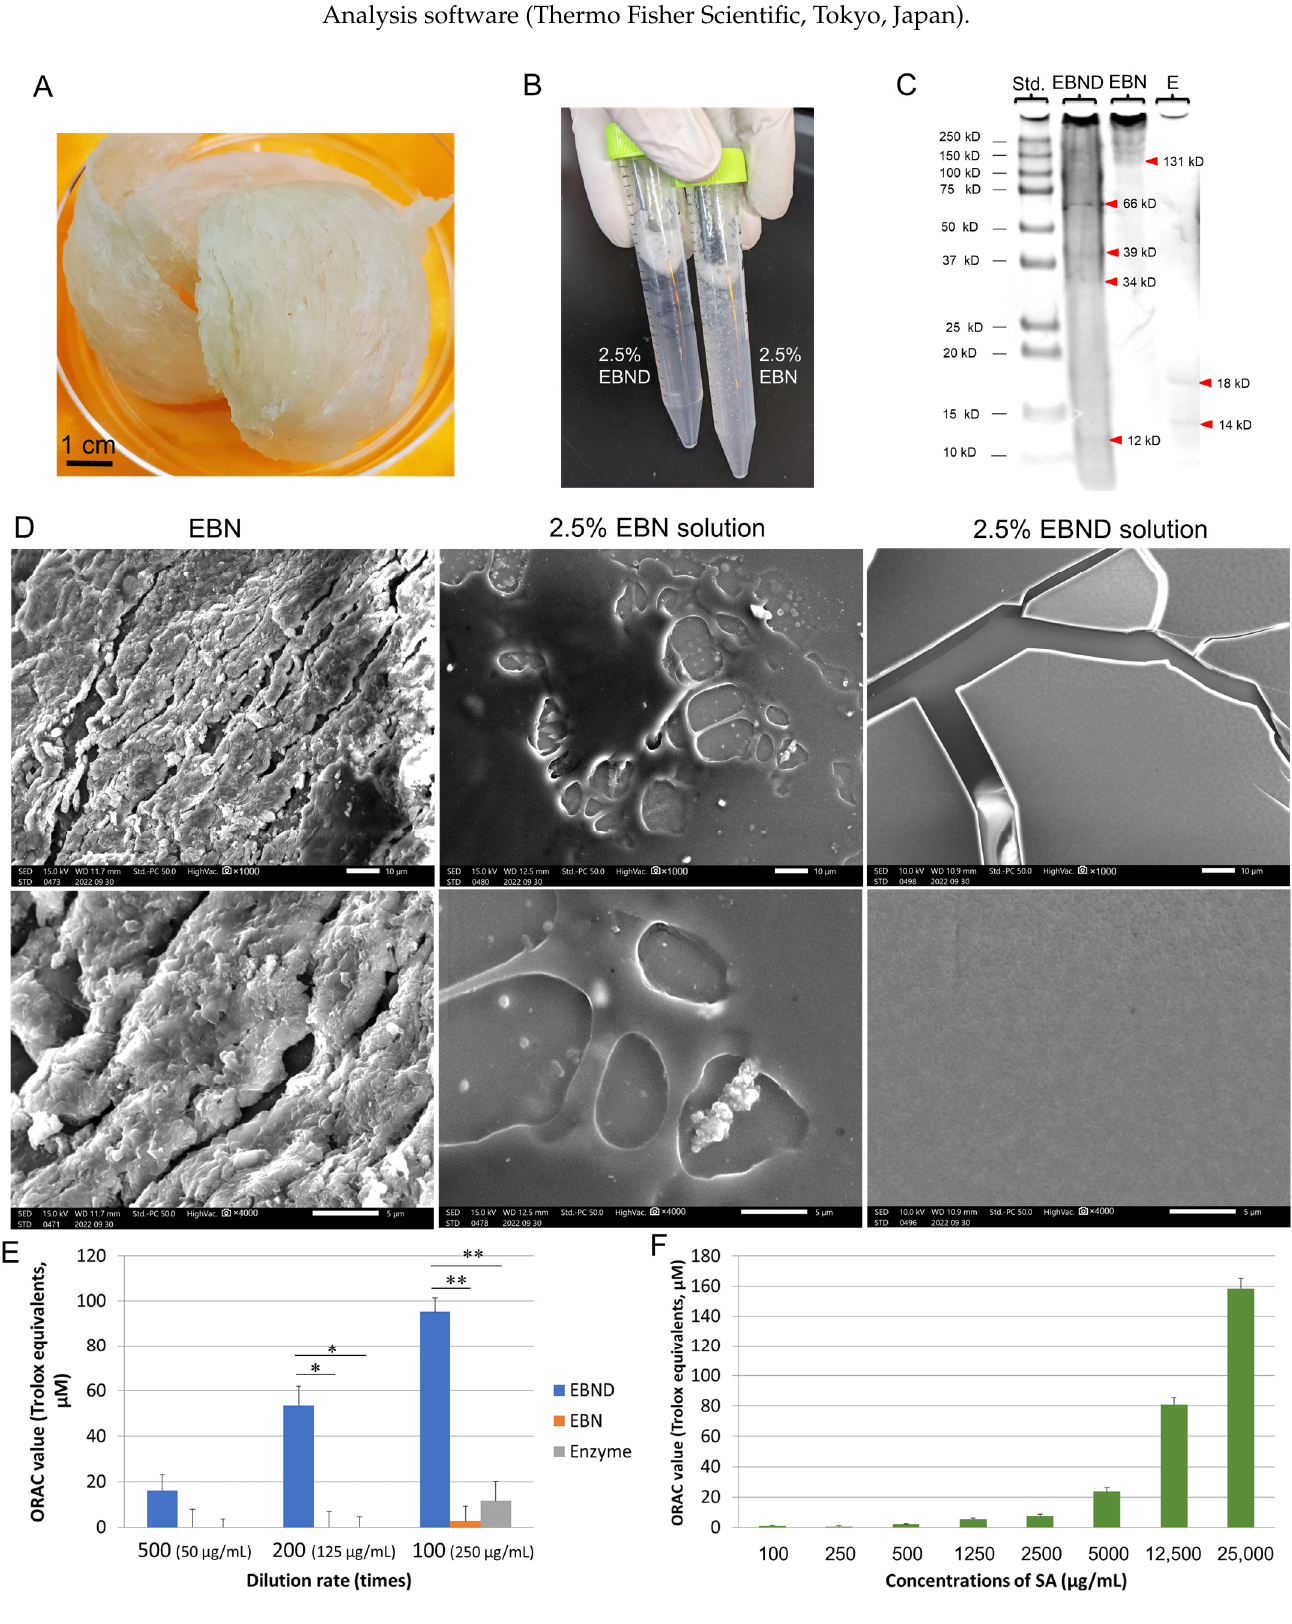
Figure 1. Protein distribution and peroxyl radical (ROO) scavenging activity of EBND: ( A ) Cup- shaped EBN (about 36 g in total); ( B ) Clarity of 2.5% EBND and 2.5% EBN; ( C ) Protein distribution and molecular weight of 2.5% EBND and EBN. Std.: protein standards; E: enzyme-only solution. Red triangles indicate bands and their molecular weight; ( D ) SEM images of EBN and 2.5% EBN and EBND solutions. Scale bars in the upper and lower panels indicate 10 and 5 μ m, respectively; ( E , F ) Peroxyl radical scavenging activity (ORAC capacity) of EBND, EBN and SA. 2.5% (25 mg/mL)